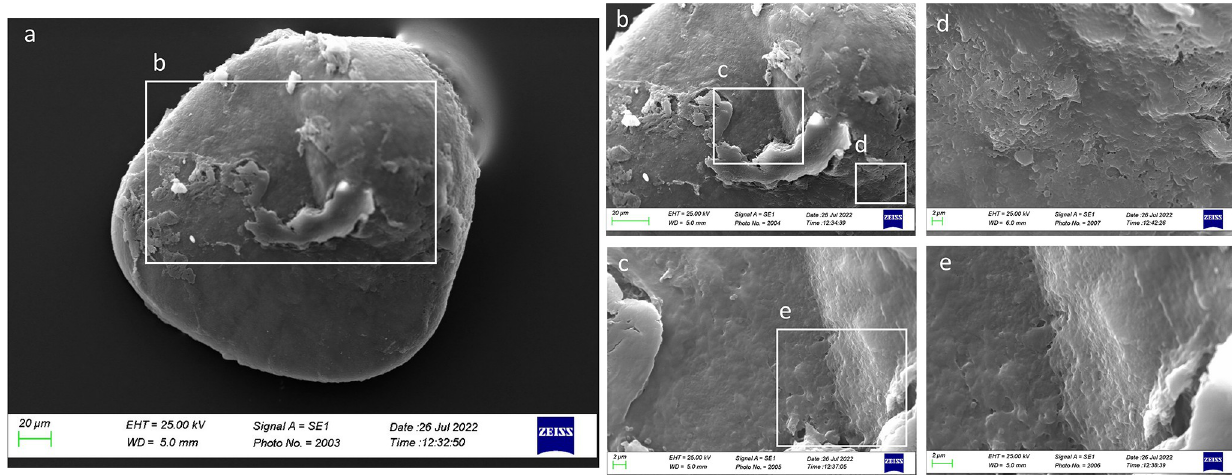
Fig 18. SEM images of a lapillus ventral surface belonging to size Class I (a) with details of sulcus lapillus (b, c) and gibbus maculae (d, e) external textural organization.